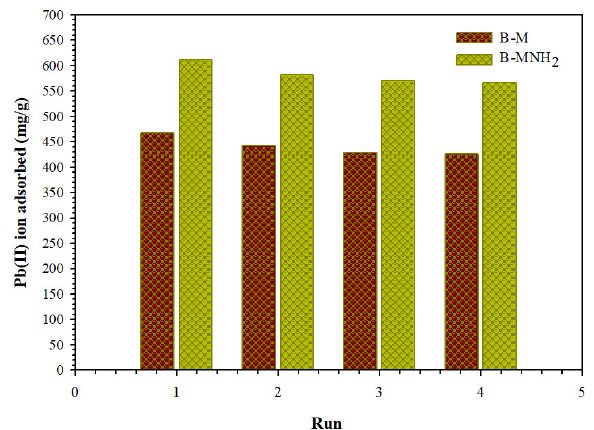
Figure 9. Repetition of the adsorbent in adsorption with a sample volume of 200 mL, an initial Pb(II) ion concentration of 100 mg L − 1 , an adsorbent mass of 60 mg, a pH of 5, and a stirring speed of 150 rpm for 360